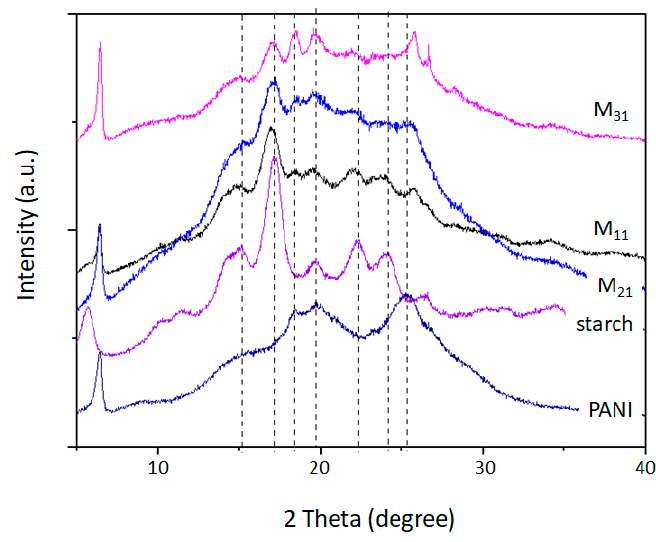
Figure 5. XRD diffractograms of starch, PANI, and PANI/starch biocomposites. Table 4. Miller indices and diffraction spacing “d” of starch and